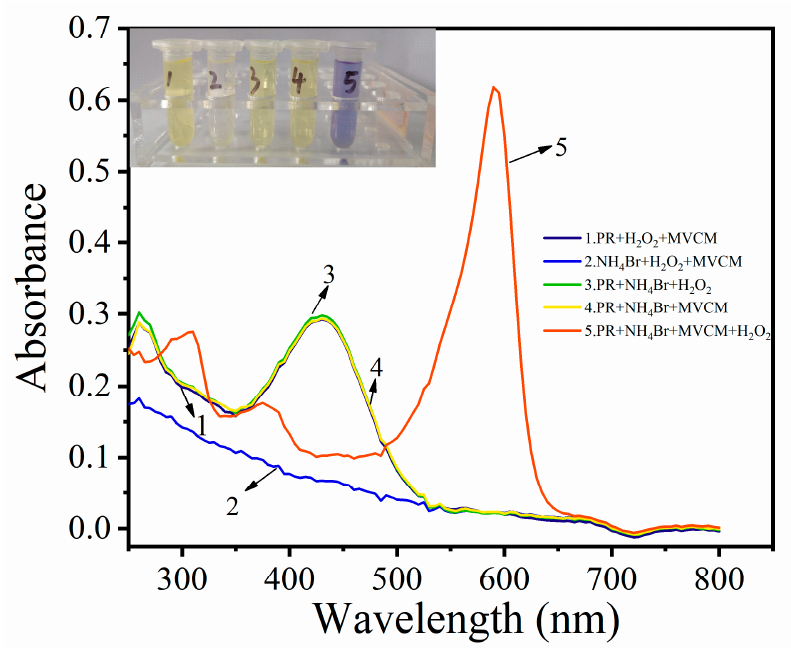
Figure 3. The absorption spectra of the different reaction systems, with the inset showing the corre- sponding photograph of the different systems.